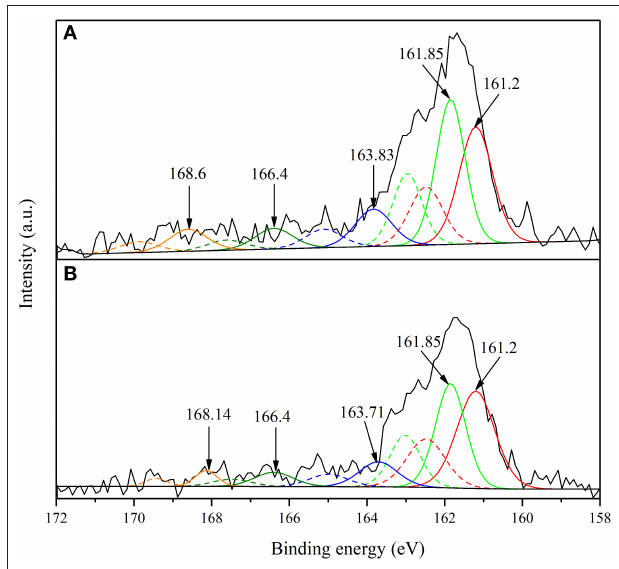
FIGURE 4 | S2p XPS spectra of smithsonite sulfidized of different times (A) 4min (B) 8min.